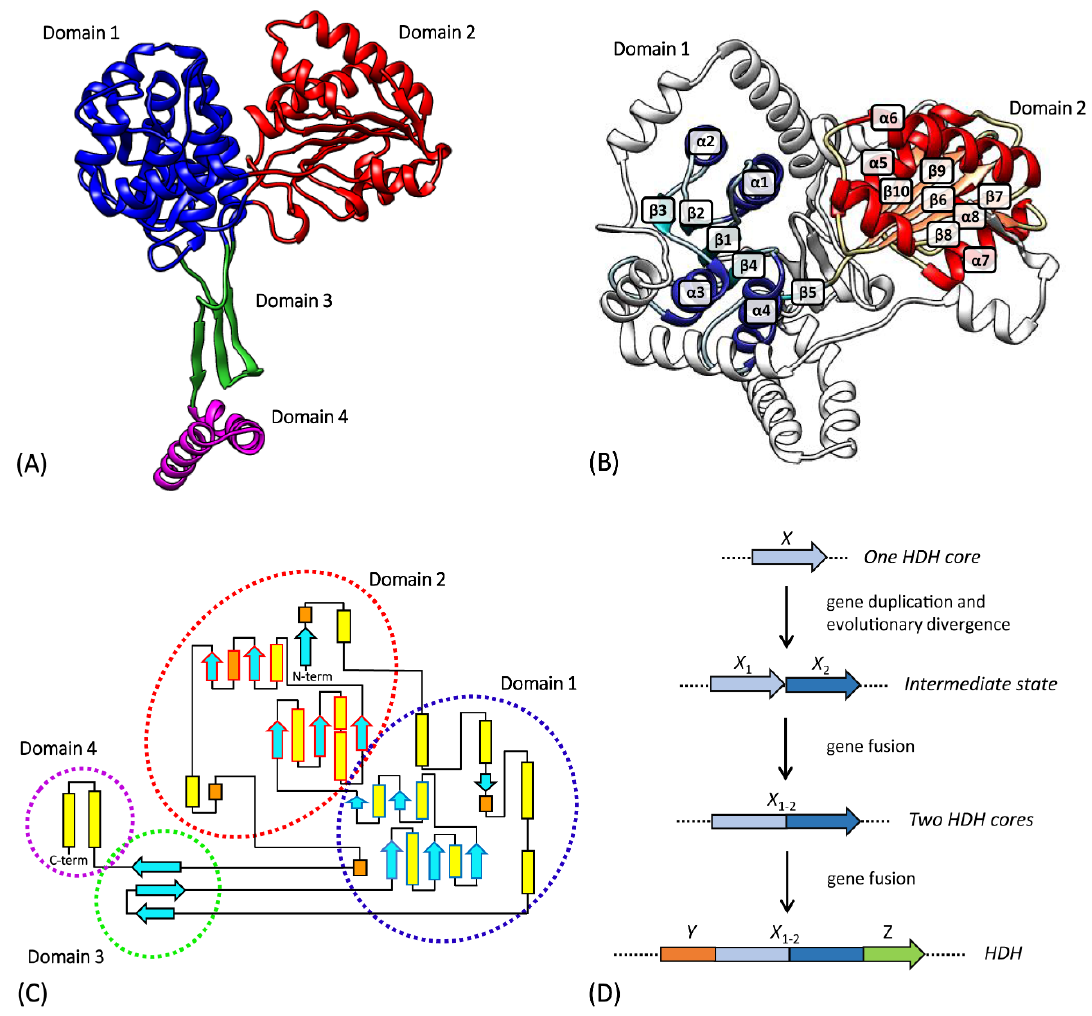
Figure 9. ( A ) Side view of the three-dimensional structure of the E. coli HisD monomer. The different domains are highlighted with different colors: Domain 1 in blue, Domain 2 in red, Domain 3 in green, and Domain 4 in violet. ( B ) Top view of E. coli HisD monomer: the elements of the two HDH cores are colored in blue (Domain 1) and red (Domain 2). α -helices and β -strands of the cores are labeled. ( C ) Topology diagram. Secondary structure elements are colored in yellow ( α -helices), orange (3 10 helices), and light blue ( β -strands). The four domains are circled with the corresponding colors used in ( A ). The cores of the two Domains are highlighted with the secondary structure element outlines colored in blue (in Domain 1) and red (in Domain 2). Diagram adapted from Barbosa et al. [18] and Ruszkowski and Dauter [58]. ( D ) Evolutionary model proposed to explain the origin and evolution of HDH.